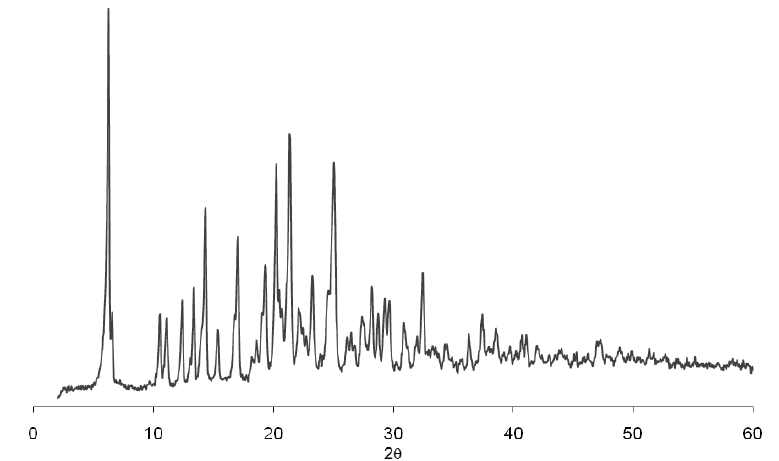
Figure 3 . Diffraction patterns of dissolution residue of efavirenz batch 2 (EFA 2).